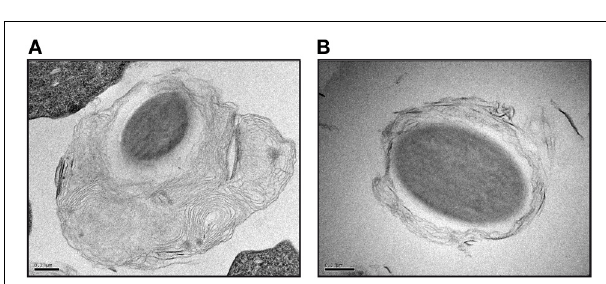
grown on B. subtilis (Benghezal et al., 2006) (A,B) and M. luteus ATCC 4698 (C) . One MLB is shown in each panel. Scale bars = 0.2 µ m.